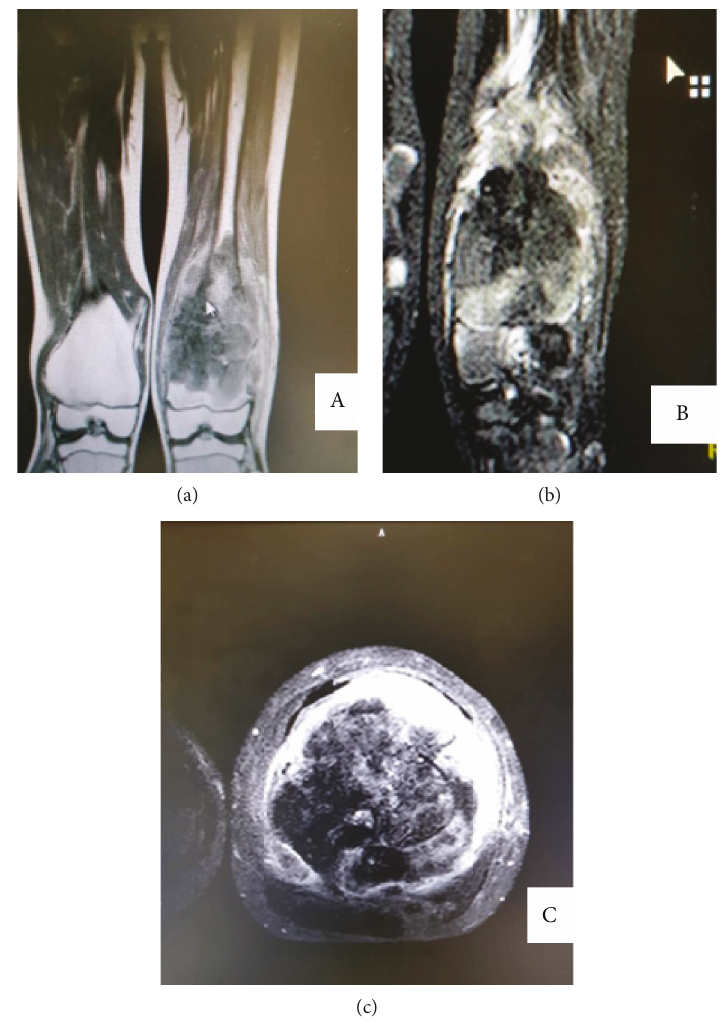
Figure 2: MRI with (a) coronal T2W1 demonstrates heterogeneous signal intensity, (b) coronal T1W1 with contrast, and (c) axial T1W1 with contrast demonstrates moderate heterogeneous enhancement. There were no skip lesions.